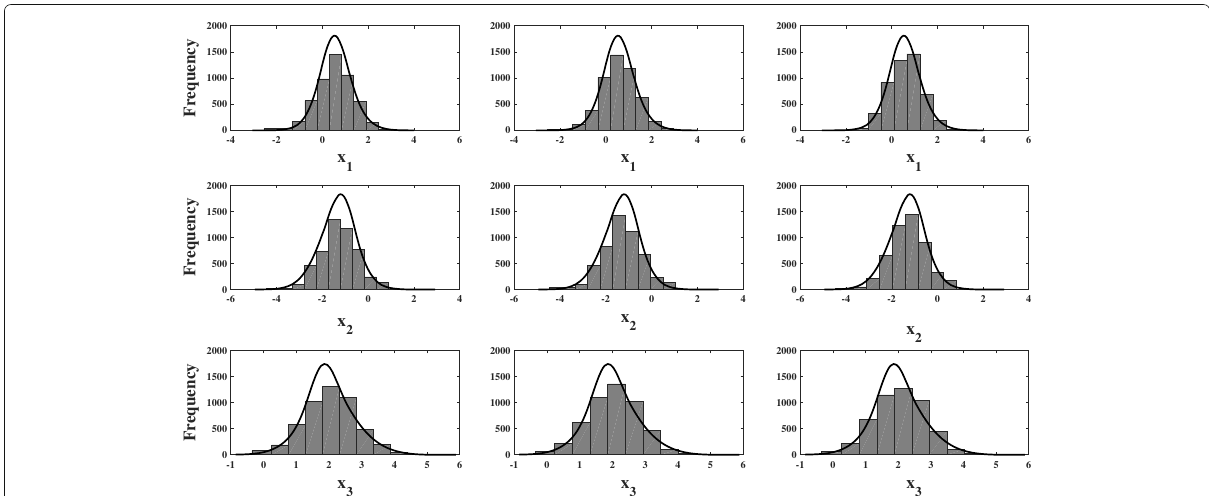
Fig. 7 Univariate frequency histograms of x n ,1 (top row) and x n ,2 (bottom row) for the Lorentz 63 model in the case of filtering at n = T . The non-normality (asymmetries) of the frequency histograms is well approximated by the fitted GMM (solid line). The histograms are constructed using (cid:4) (cid:3) M , w i resamples from x i T T i = 1